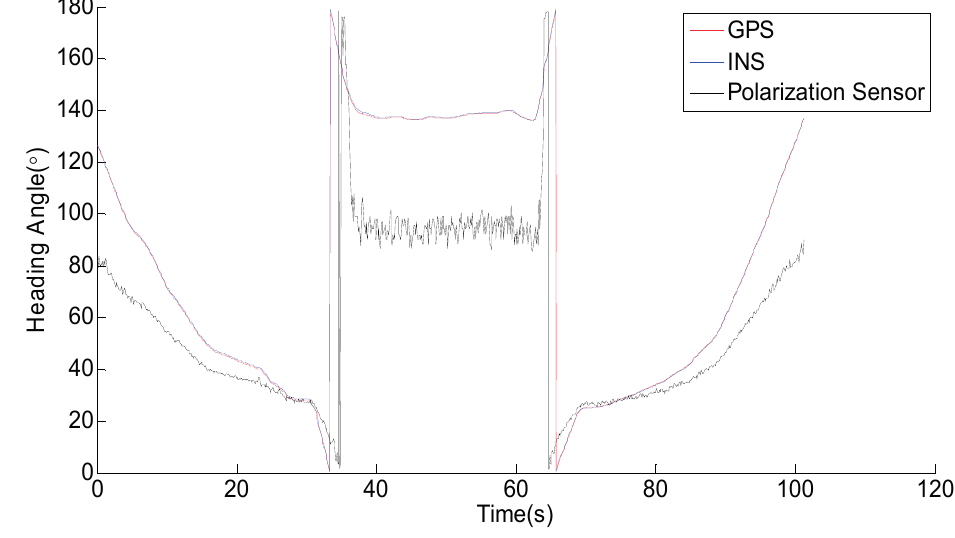
Figure 10. The characteristic curves of the polarization sensor with GPS and